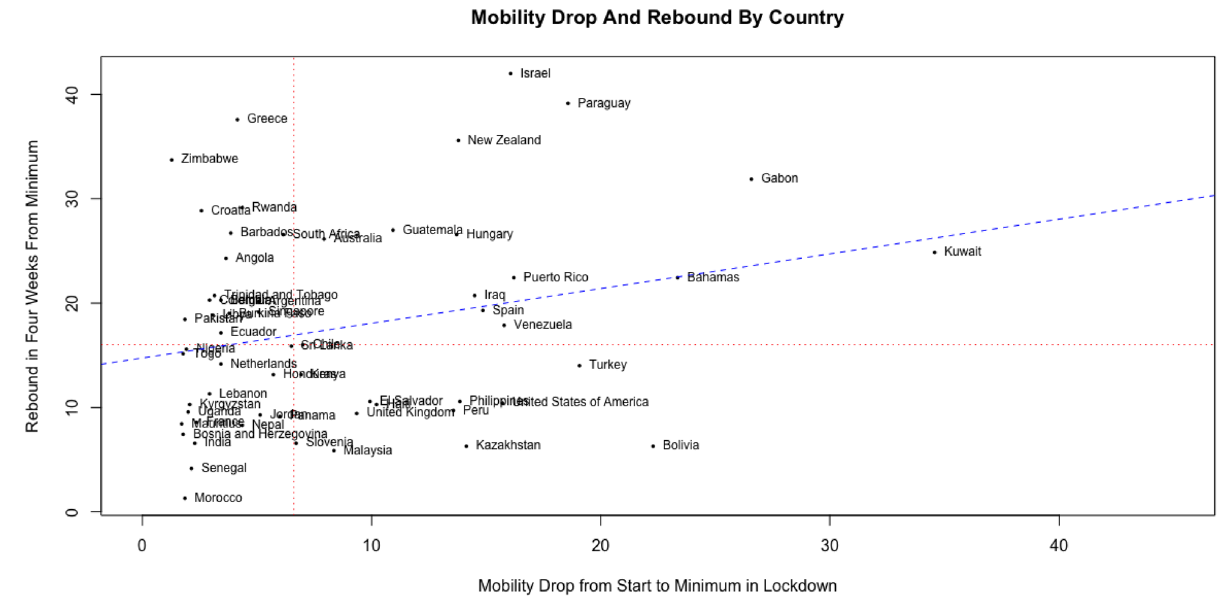
Figure 5. Mobility drop and rebound across n = 59 countries. The horizontal axis represents the mobility drop from the start of the lockdown until reaching the minimum mobility level during the lockdown. The vertical axis represents the rebound in mobility in 4 weeks from the day when minimum mobility levels were achieved during the